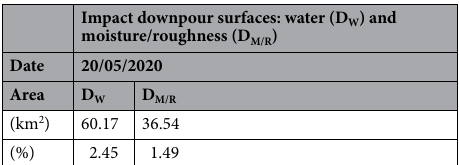
Impact downpour surfaces: water (D W ) and moisture/roughness (D M/R